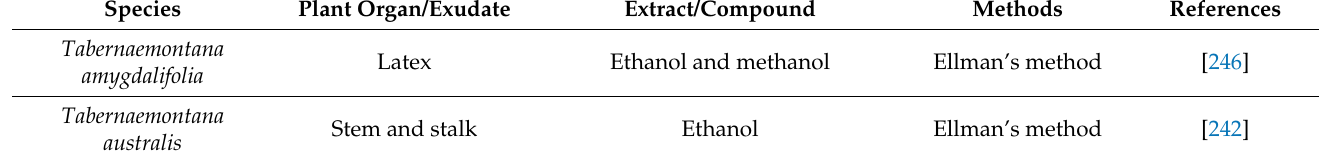
Table 9. Antiacetylcholinesterase activities of extracts and compounds isolated from Tabernaemontana species.